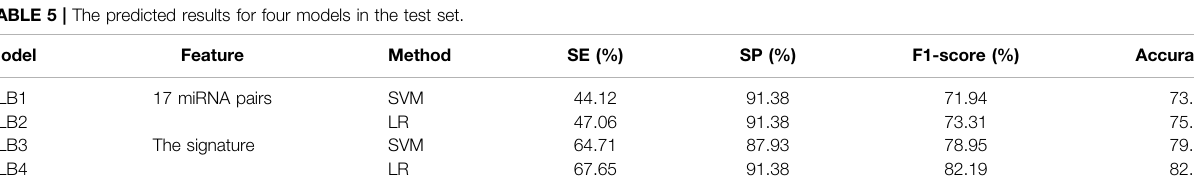
TABLE 5 | The predicted results for four models in the test set.